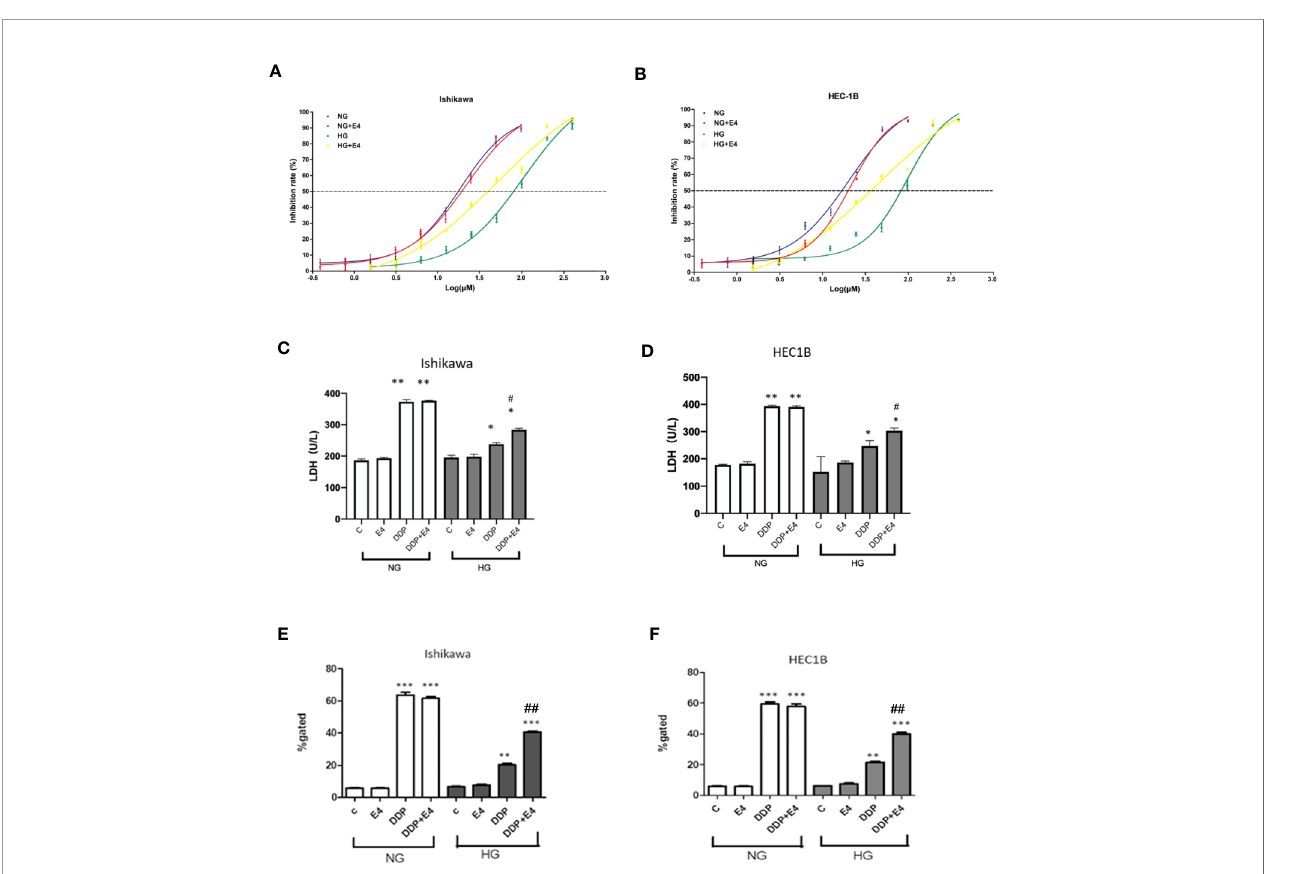
FIGURE 1 | Hyperglycemia may help alleviate cancer cells from the DDP-induced cytotoxicity, an effect attenuated by Exe-4. Ishikawa (A) and HEC1B (B) were grown under NG and HG conditions for eight weeks, respectively, then further incubated for 48 h with or without Exe-4 (10 nM) to assess cell viability. IC50 was calculated as the concentration of DDP that kills 50% (blue line) of cells. The IC50 values of DDP for Ishikawa in the NG, NG + Exe-4, HG, and HG + Exe-4 groups were 16.7 3µM, 18.569 m M, 75.283 m M, and 36.92 m M, respectively (A) . Those of DDP for HEC1B in the NG, NG + Exe-4, HG and HG + Exe-4 groups were 15.428 m M, 18.621 m M, 74.857 m M, and 35.774 m M, respectively (B) . (C, D) LDH levels in supernatants from Ishikawa (C) and HEC1B (D) cells cultured under HG versus NG with various treatments. E and (F) ROS amounts in Ishikawa (E) and HEC1B (F) cells cultured under HG or NG with different treatments. ∗ p < 0.05, **p < 0.01, ***p < 0.001 versus control group or corresponding treatment group under NG; # p < 0.05, ## p < 0.01 versus DDP group under